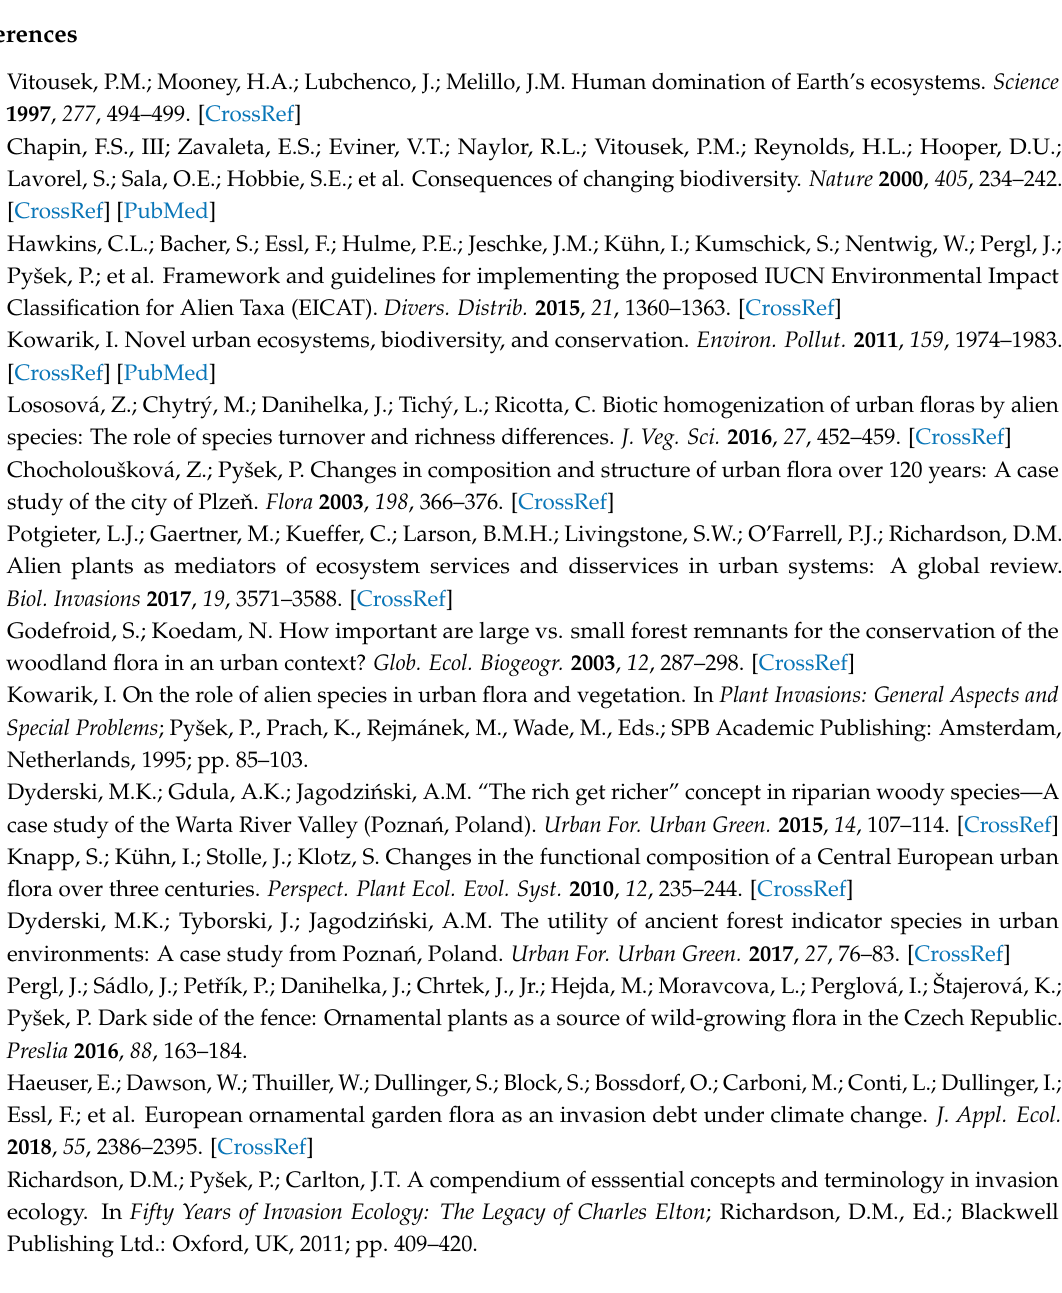
Table S5. Result of Poisson GLM of alien species richness, estimated using the stats::glm() function. AIC 0 refers to AIC of intercept-only model (null model). Table S6. Result of zero-inflated beta regression of alien species cover, estimated using the gamlss::gamlss() function. AIC 0 refers to AIC of intercept-only model (null